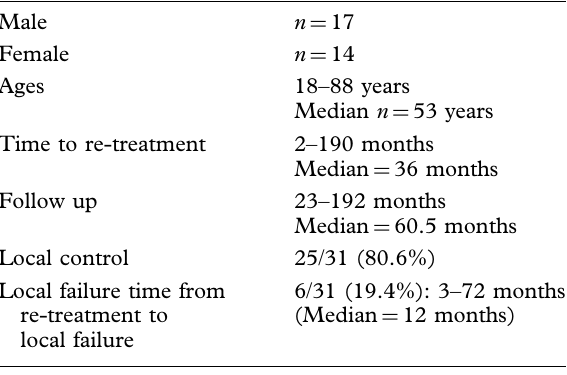
Table 1. Patient